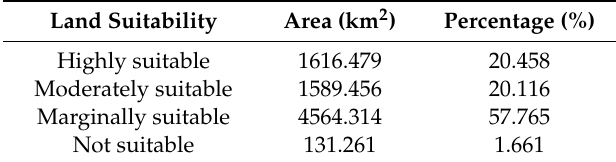
Table 8. Land suitability for surface irrigation in the Anger basin.